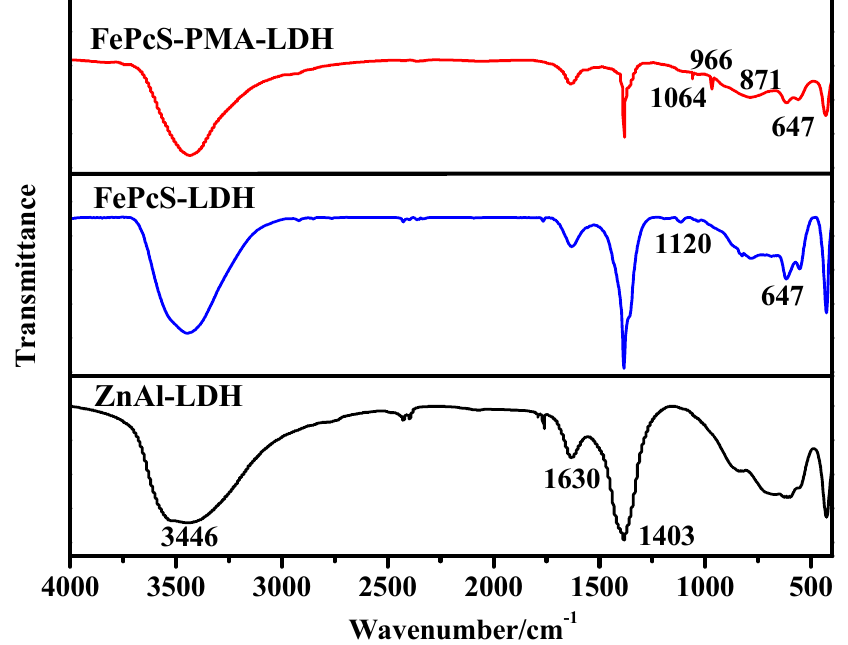
Figure 2. Fourier transform infrared (FTIR) spectra of ZnAl–LDH, FePcS–LDH, and